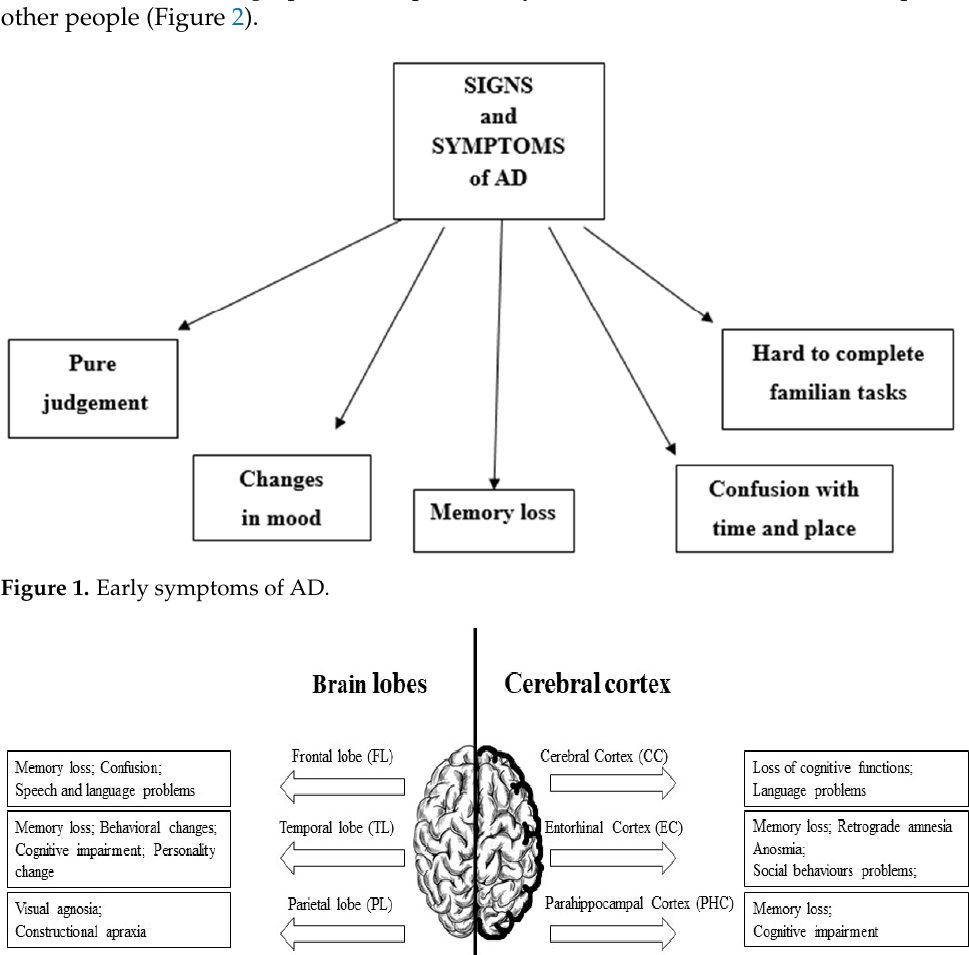
Figure 2. Effects of damage to individual parts of the brain throughout the course of AD.